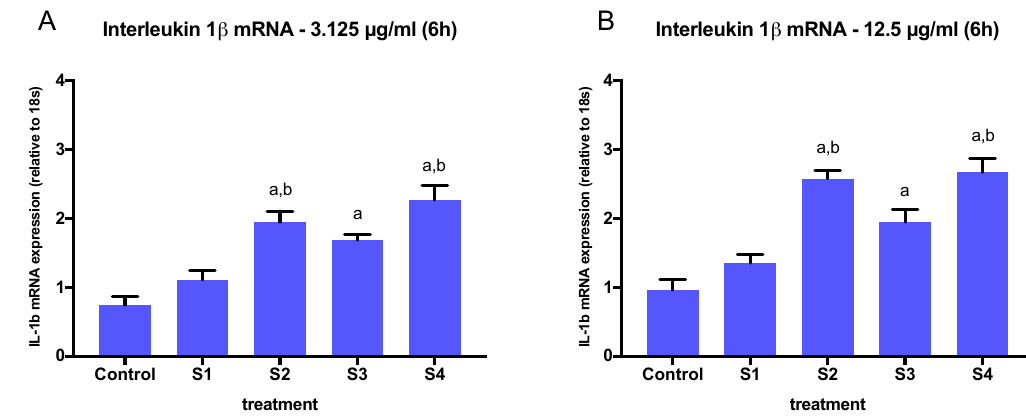
Figure 6. Human IL-1 β mRNA (IL1B) expression (relative to 18S expression) in BEAS-2B cells treated with S1–S4 soot at 3.125 µ g / mL ( A ) or 12.5 µ g / mL ( B ) for 6 h. The graphs summarize data from three independent experiments ( n = 3 replicates per experiment), with results normalized to controls (exposed to methanol) and expressed as mean ± SEM. a: different from control, b: different from S1 ( p < 0.05). One-way ANOVA ( p < 0.001, F (4, 20) = 20.47).